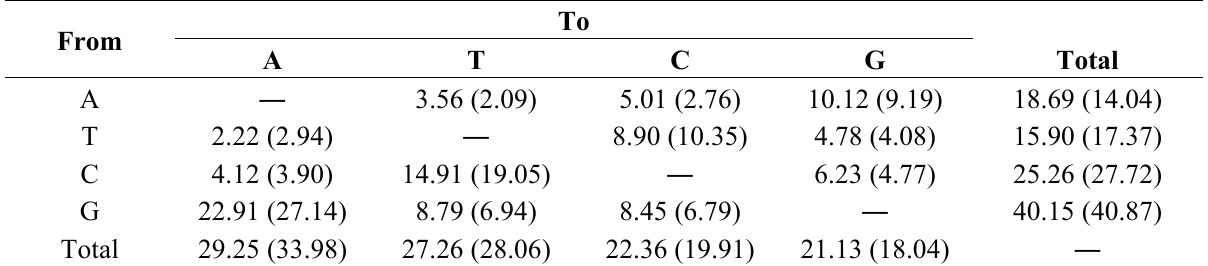
Table 1. Pattern of nucleotide substitution in neurodegenerative diseases (NDs) and non-NDs a . From